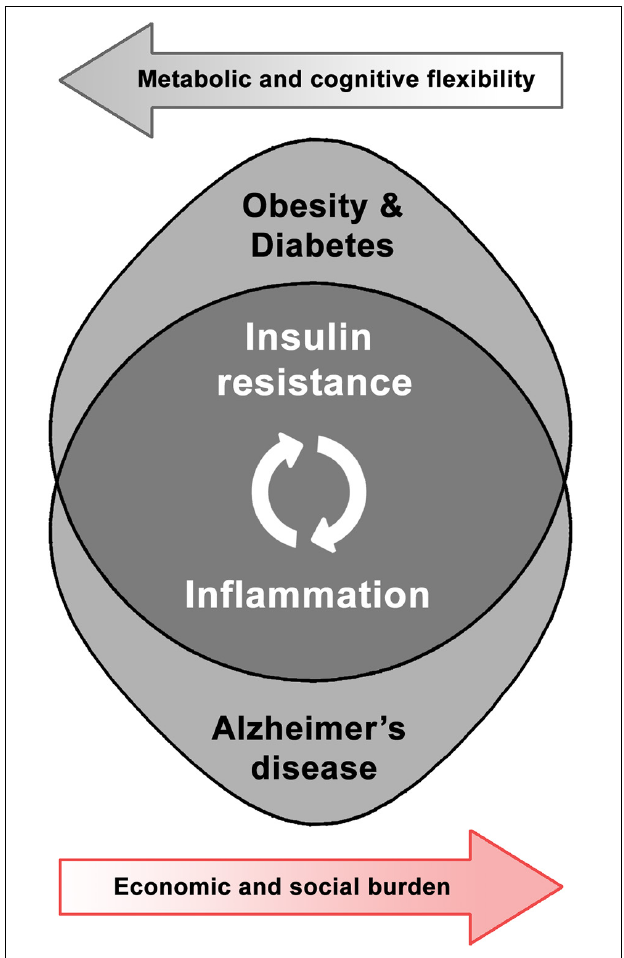
FIGURE 1 | Shared pathophysiological pathways and synergic burden of obesity-related disorders and Alzheimer’s disease.